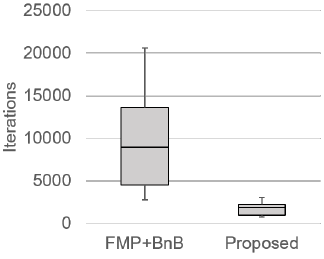
Figure 9. Number of iterations for Trees